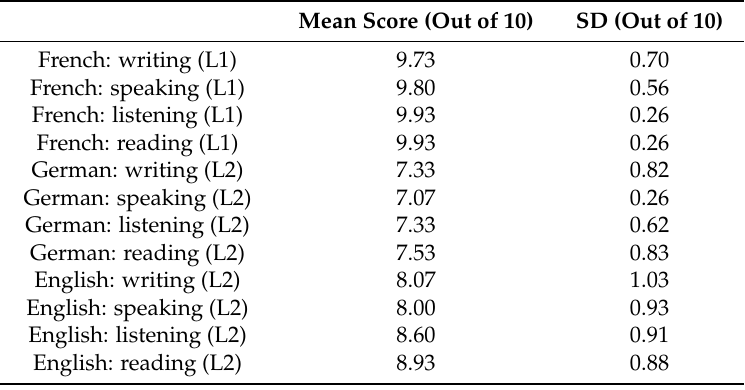
Table 2. Self-rated proficiency scores for the French-German multilingual